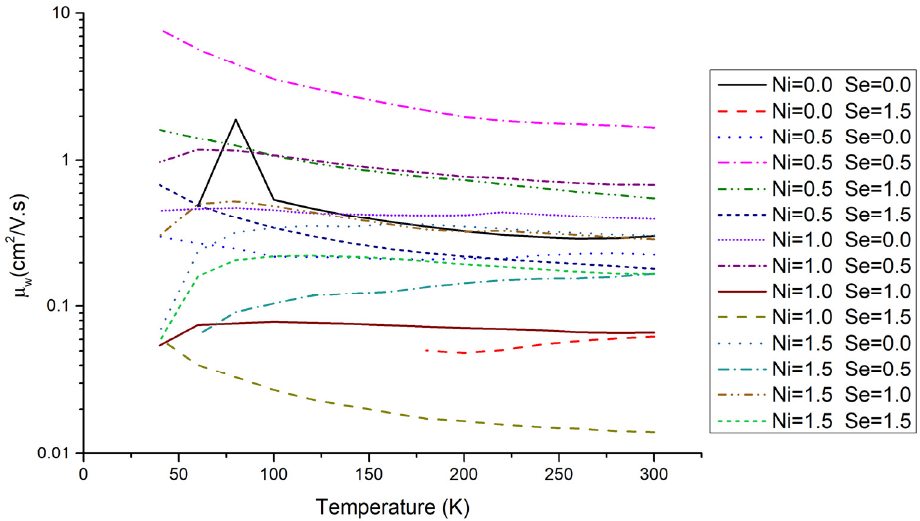
Figure 9. Weighted mobility as a function of temperature for the Cu 12 − x Ni x Sb 4 S 13 − y Se y annealed sam ‐ ples. annealed